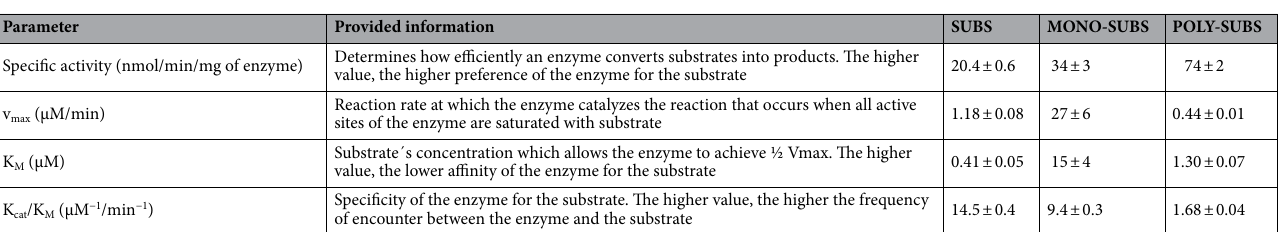
Table 1. Kinetic parameters on day 0 of trypsin using different fluorogenic substrates. Data are means ± SE of three replicates.